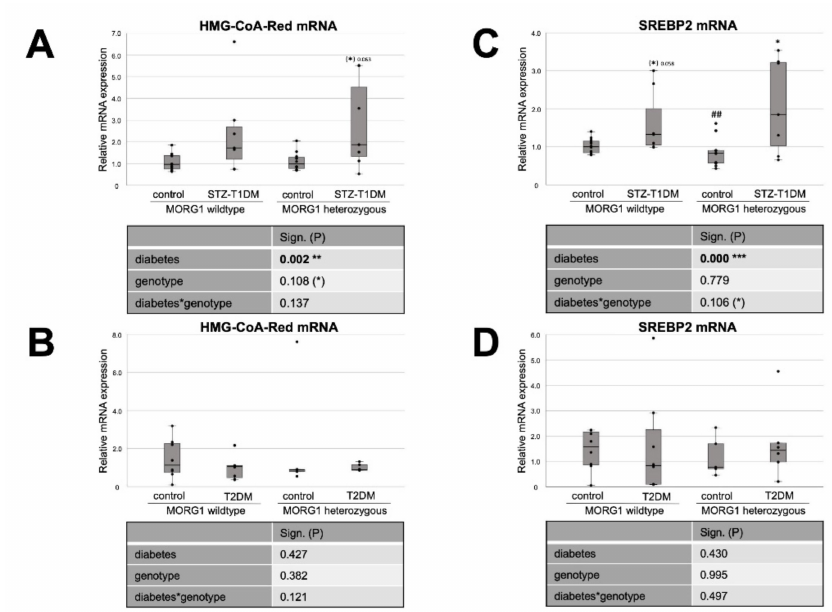
Figure 2. Effect of MORG1 and diabetes on renal expression of key enzymes of cholesterol synthesis. ( A , B ) Real-time analysis of HMG-CoA-Red (3-hydroxy-3-methylglutaryl-CoA-reductase) mRNA expression in STZ-T1DM and T2DM. ( C , D ) Real-time mRNA analysis of SREBP2 (sterol regulatory element-binding protein 2) in STZ-T1DM and T2DM. ( A – D ) The significances shown in the tables were assessed by two-way ANOVA with diabetes (control or STZ-T1DM/T2DM) and genotype (MORG1 wild-type or MORG1 heterozygous) as the two factors. Diabetes, genotype: main effect of diabetes/genotype, respectively. Diabetes*genotype: interaction. Bold: statistically significant. (*) Biologically relevant. Significances shown next to each bar were assessed by using Mann–Whitney U test; * p ≤ 0.05 in between same genotype; ## p ≤ 0.01 in between different genotypes; (*) biological relevant in between same